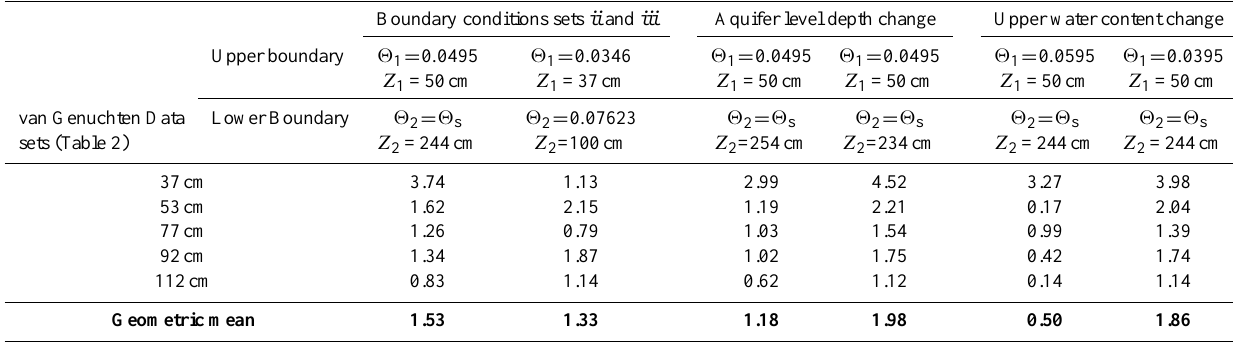
Table 4. The steady state capillary rise rate (cm) for 35 days based on Hydrus simulations for five van Genuchten data sets (Table 2) and six sets of boundary conditions. Boundary conditions sets ii and iii are similar to Table 3. (In bold: geometric mean). Z 1 is the depth of upper limit (cm), Z 2 the depth of lower limit (cm). 2 1 and 2 2 are the water contents at depths Z 1 and Z 2 . 2 s is the saturated water content. Boundary conditions sets ii and iii correspond to field measured